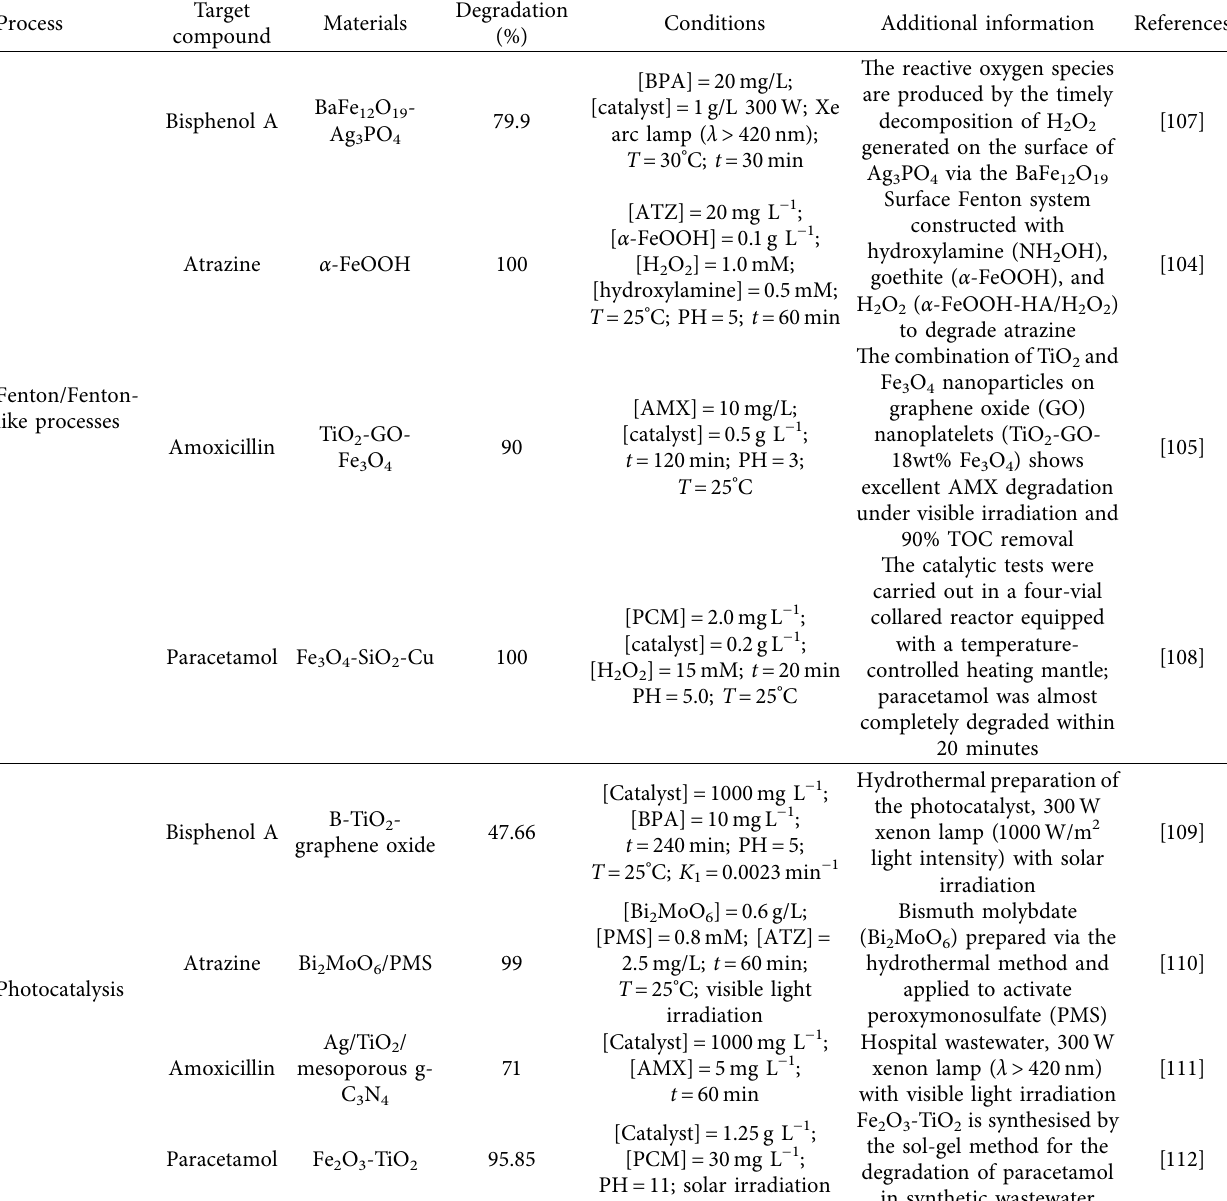
Table 4: Advanced oxidation processes for the degradation of emerging pollutants present in